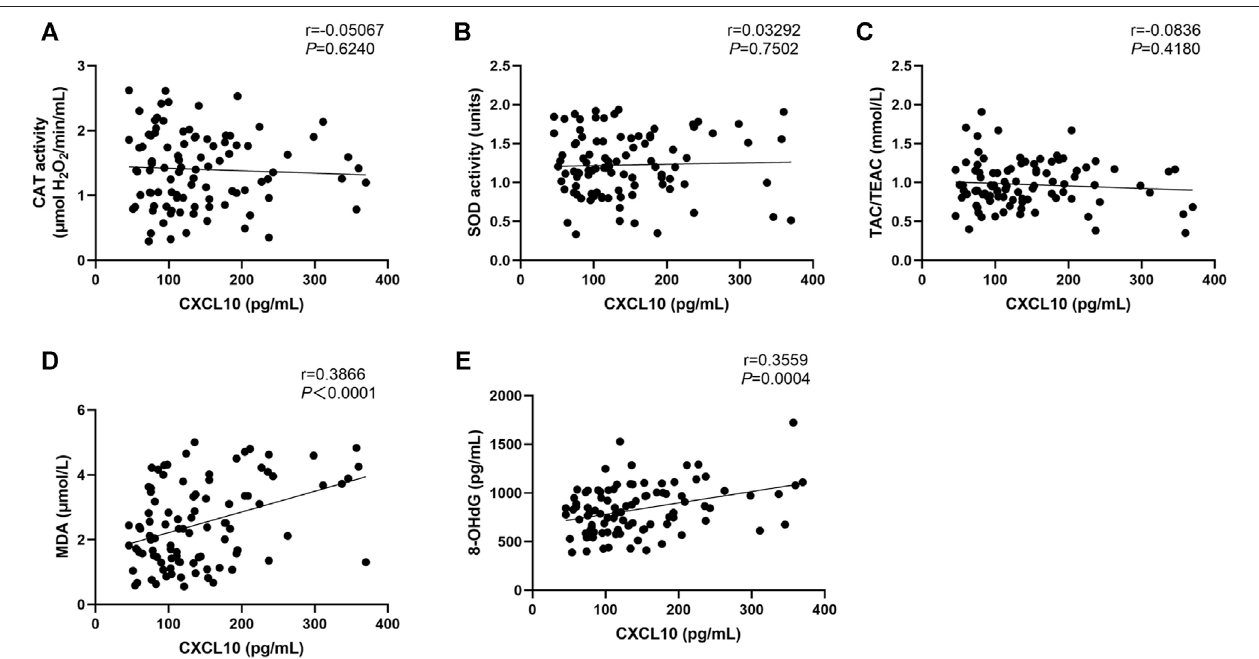
FIGURE 2 | Correlation between CAT (A) , SOD (B) , TAC (C) , MDA (D) , and 8-OHdG (E) levels with the CXCL10 expression in NSV patients. CAT, catalase; SOD, superoxide dismutase; TAC, total antioxidant capacity; TEAC, Trolox equivalent antioxidant capacity; MDA, malondialdehyde; 8-OHdG, 8-hydroxy-2-deoxyguanosine.